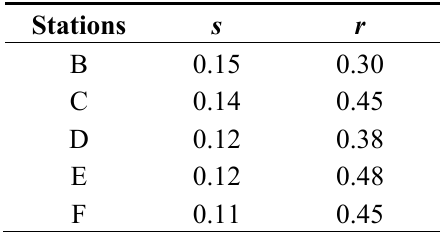
Table 6. Convection and diffusion numbers.